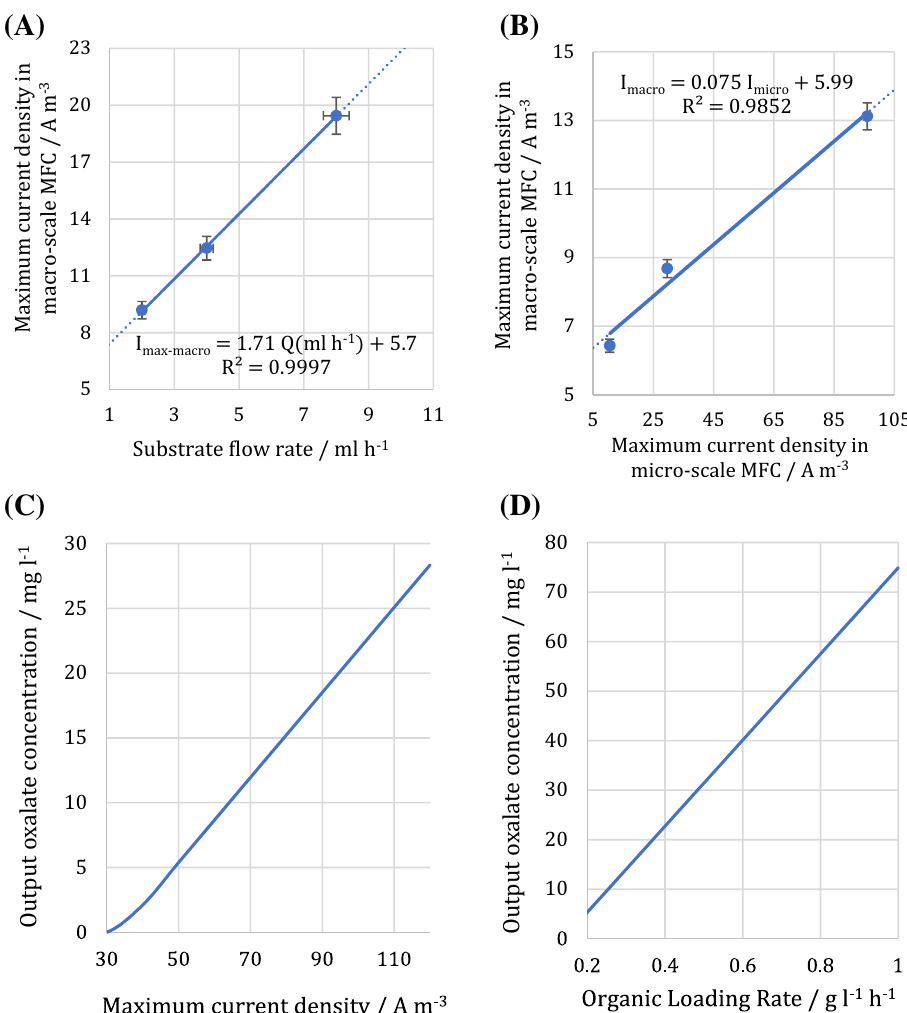
Figure 6. ( A ) The maximum produced current density versus the oxalate flow rate in the macro-scale MFC. ( B ) The variation of maximum current density in the macro-scale MFC versus the related value in the micro- scale MFC. ( C ) The variation of oxalate concentration in the outlet stream of the micro-scale MFC. Oxalate inlet concentration was 156 mg l −1 . ( D ) Oxalate concentration in outlet stream based on the organic loading rate in the micro-scale MFC. The error bars represent the variation of power and current densities among repeated